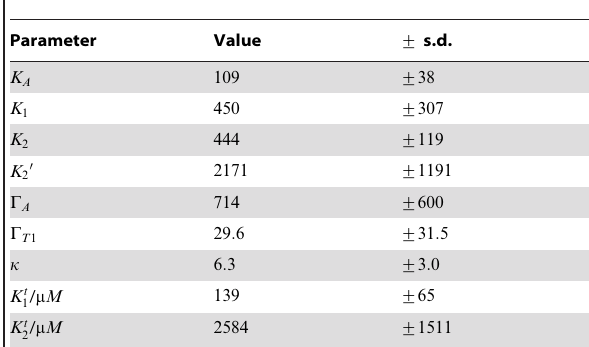
Table 1. Yeast: parameters.